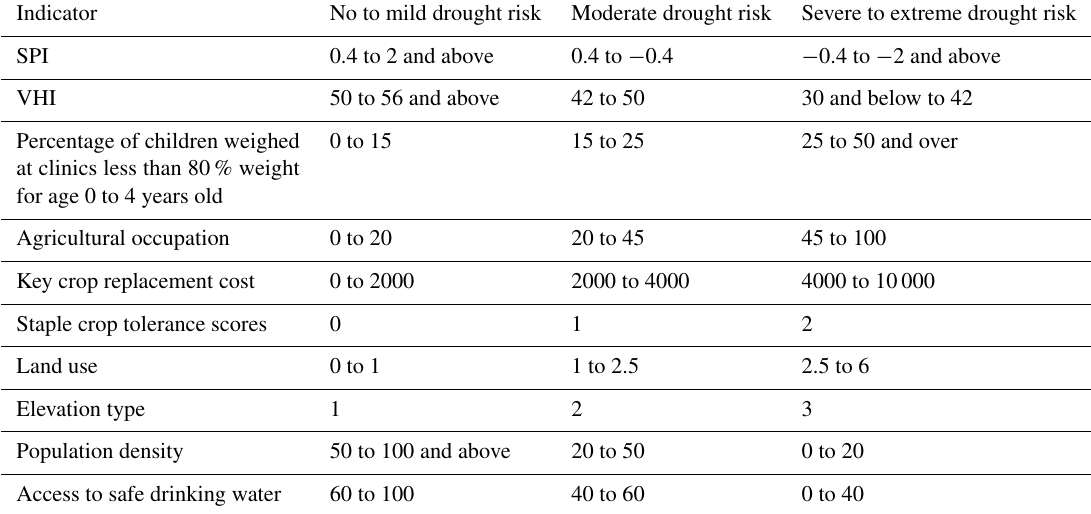
Table 3. Indicator thresholds that signal different stages of drought risk. These thresholds have been decided upon based on use in past studies (Rahmati et al., 2020; Nasrollahi et al., 2018; Aitkenhead et al., 2021), the advice of the PNG National Weather Service, as well as past data trends in PNG (Chua et al.,